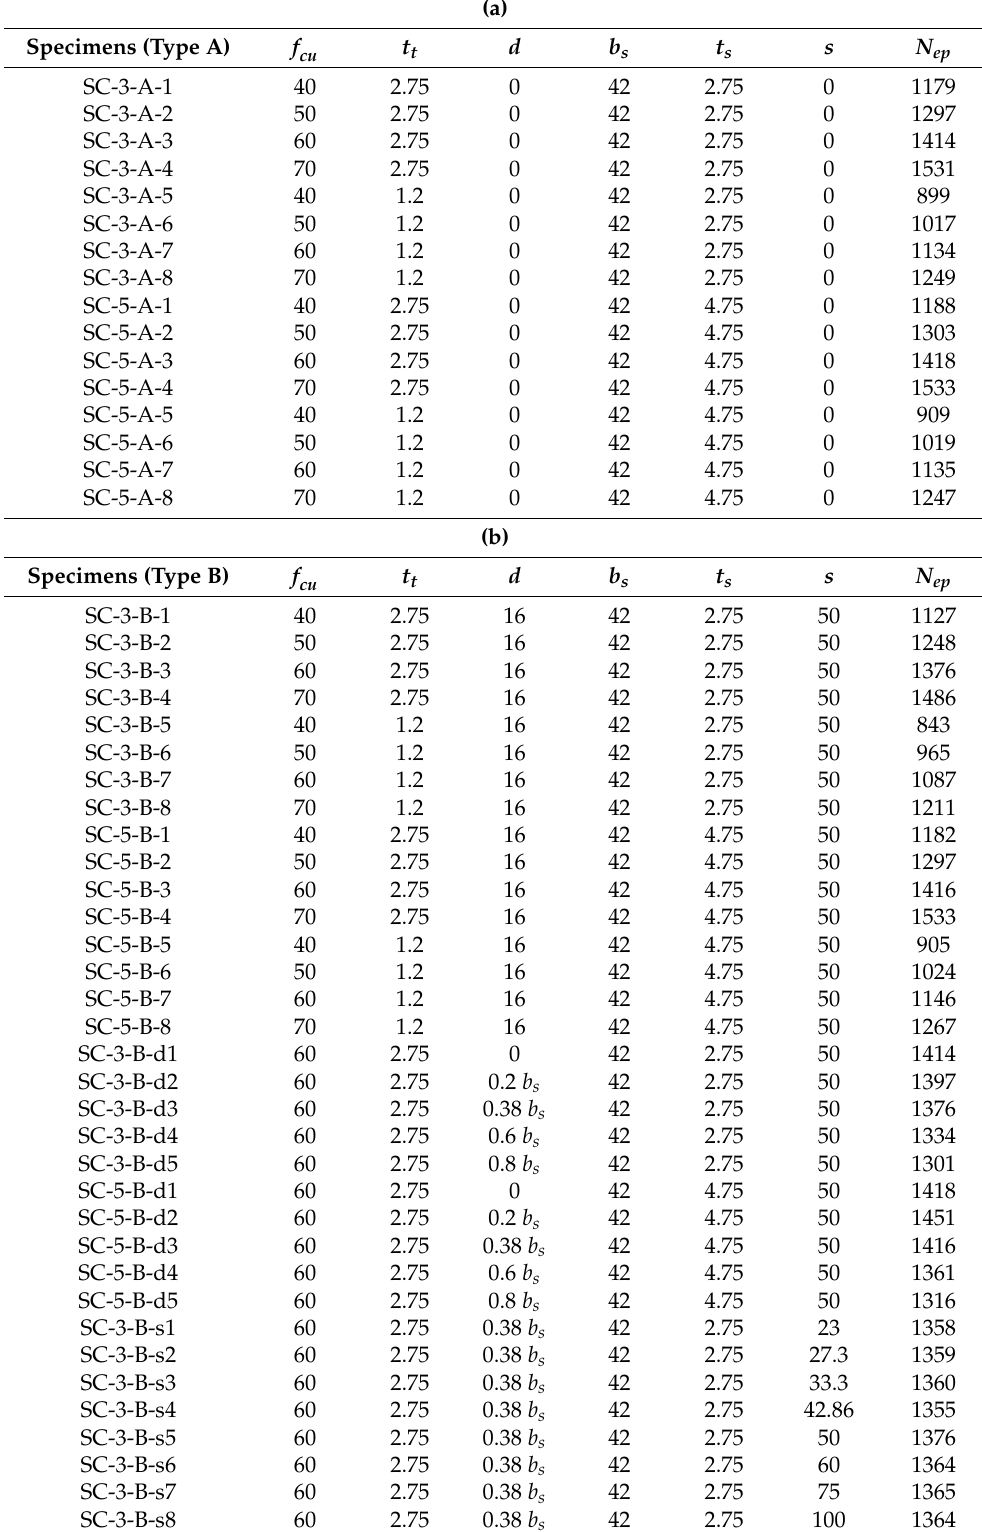
Table 2. Parametric analysis of CFST column under axial